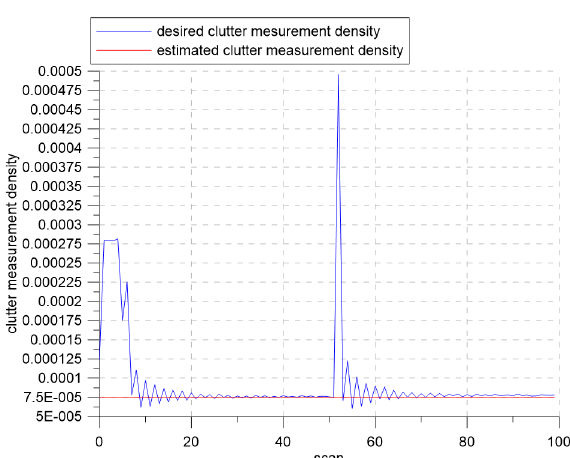
Figure 17. Position RMSE for Scenario 2.